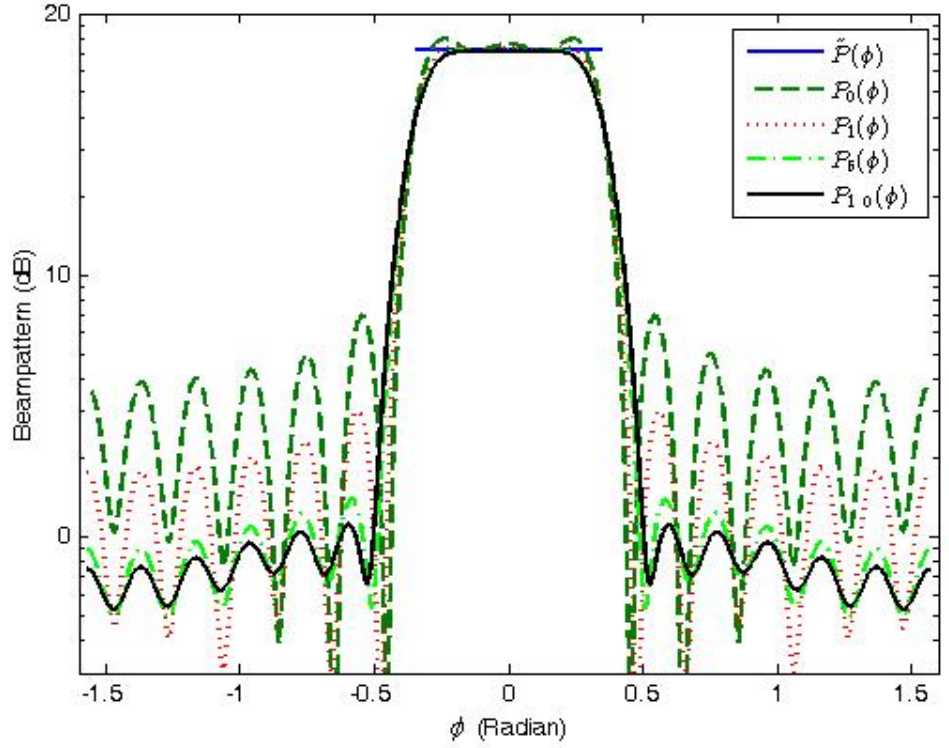
Figure 3. The transmit beampatterns after using the cosine method ( M = 16).